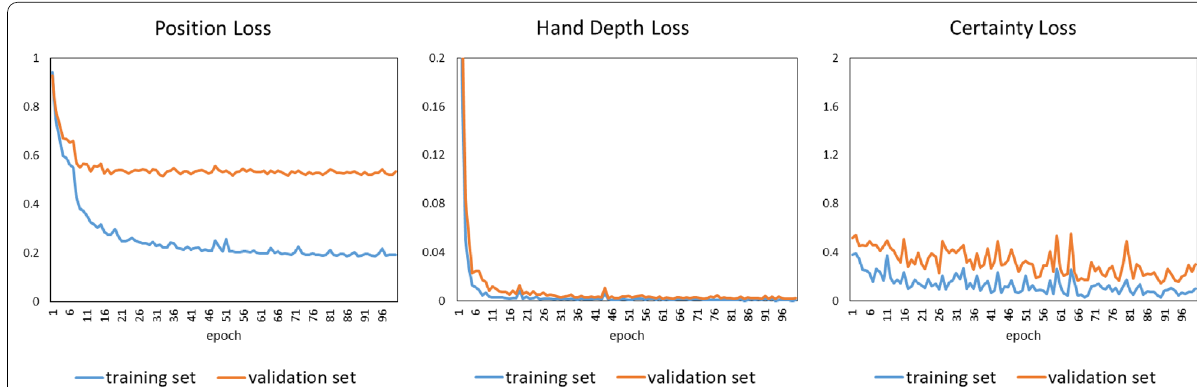
Fig. 8 Loss of the grasping position, the hand shape, and the certainty in each epoch